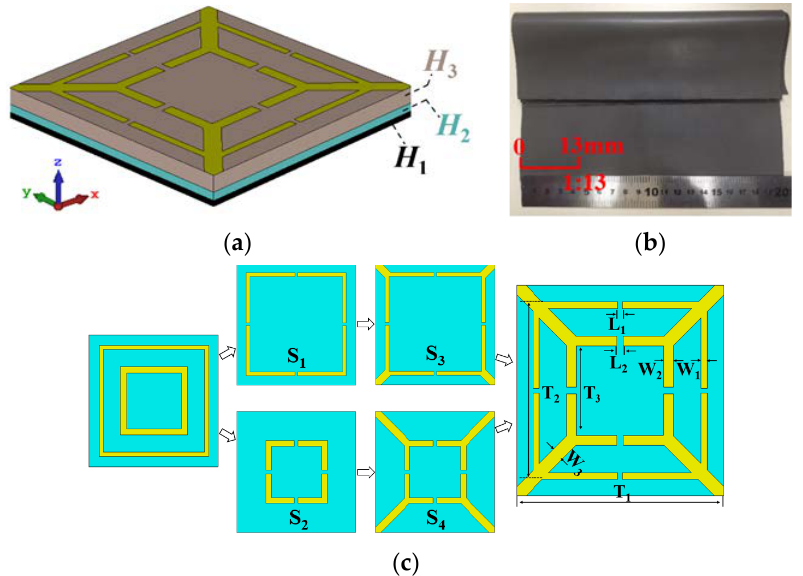
Figure 1. Schematic of the proposed absorber; ( a ) is the side view, ( b ) is the magnetic substrate, and ( c ) is the formation process of the unit cell.